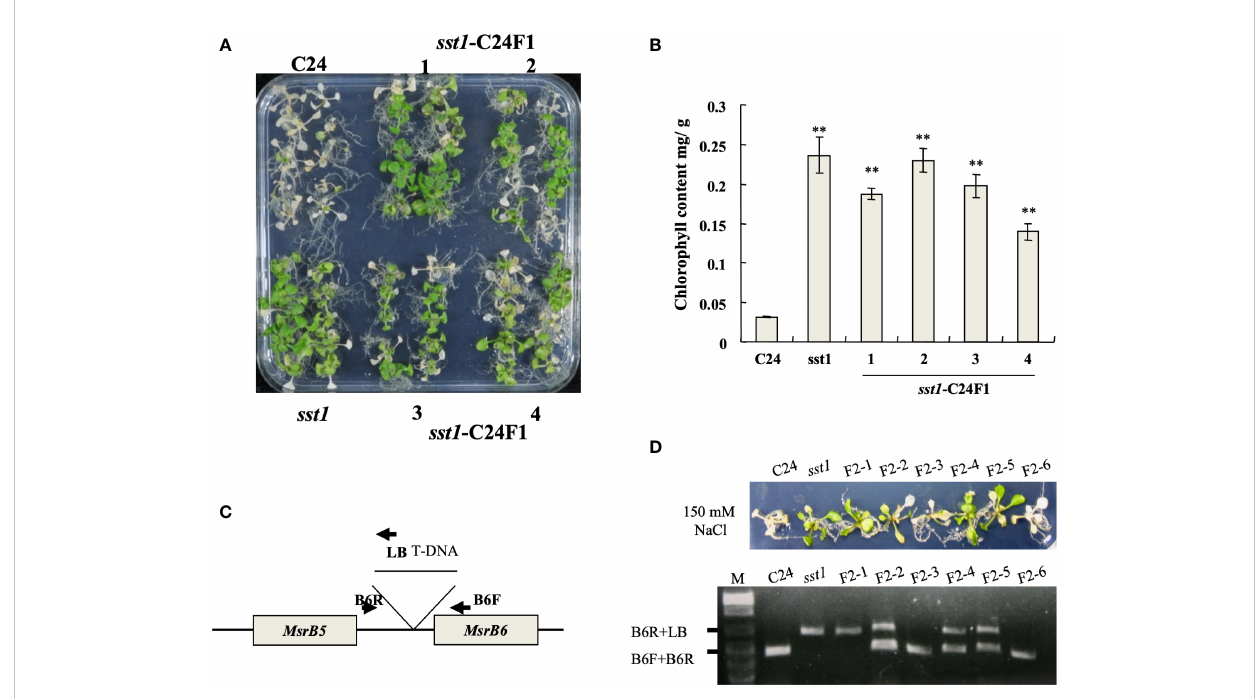
FIGURE 2 T-DNA insertion in sst1 associated with salt-stress-tolerant phenotype. (A) Plants of the wild type (C24), sst1 and their F1 progeny were treated with 150 mM NaCl; (B) Chlorophyll content after photographing. Data are means ± SD (n = 20) of three independent experiments. *, P < 0.05. (C) Annotation of primer and position for PCR ampli fi cation; (D) Salt-stress (150 mM) treatment of C24, sst1 and six independent F2 progeny and genomic PCR with the primers is indicated in panel (C) . Data are means ± SD (n = 20) of three independent experiments. **, P